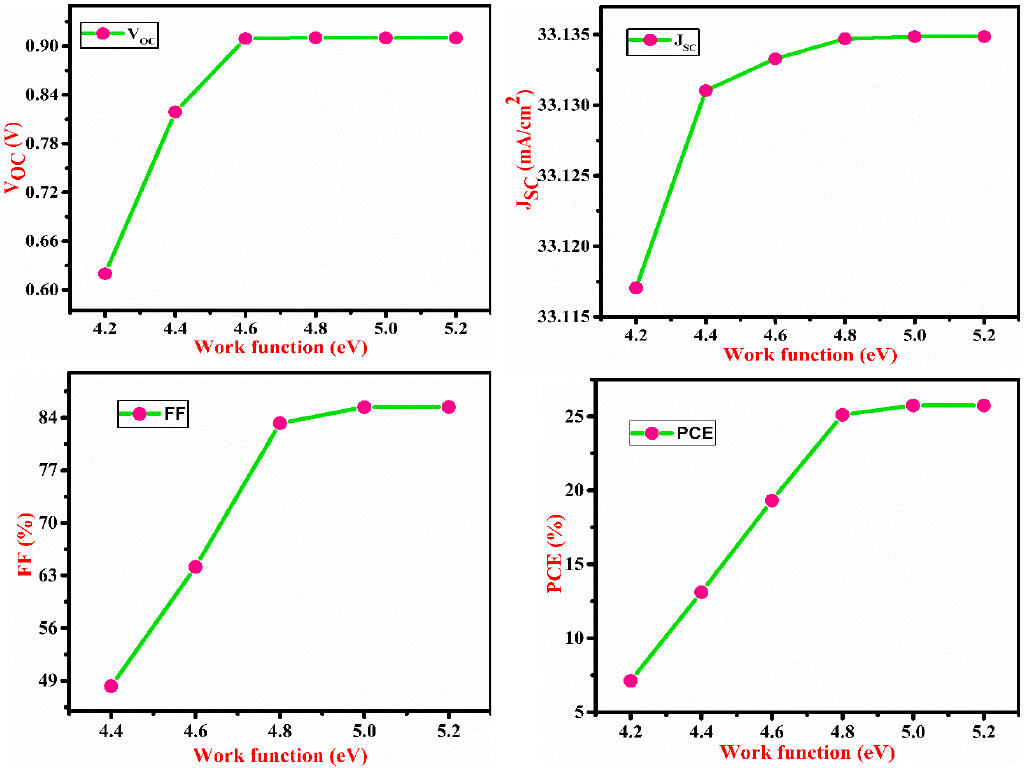
Figure 6. Impact of back contact metal work function on V OC , J SC , FF and PCE of the proposed cell.